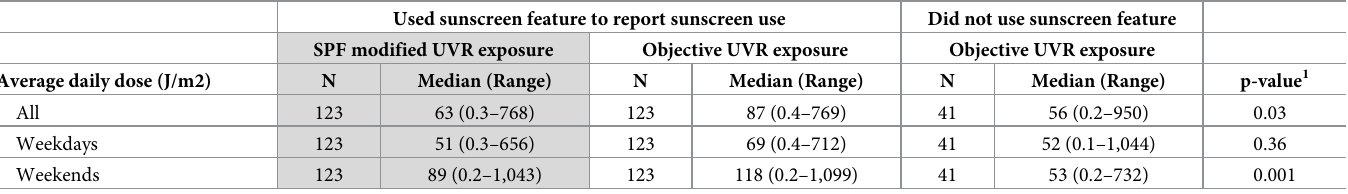
Table 6. SPF modified and objective UVR exposure data during the intervention period among those in the intervention group by use of the sunscreen feature.